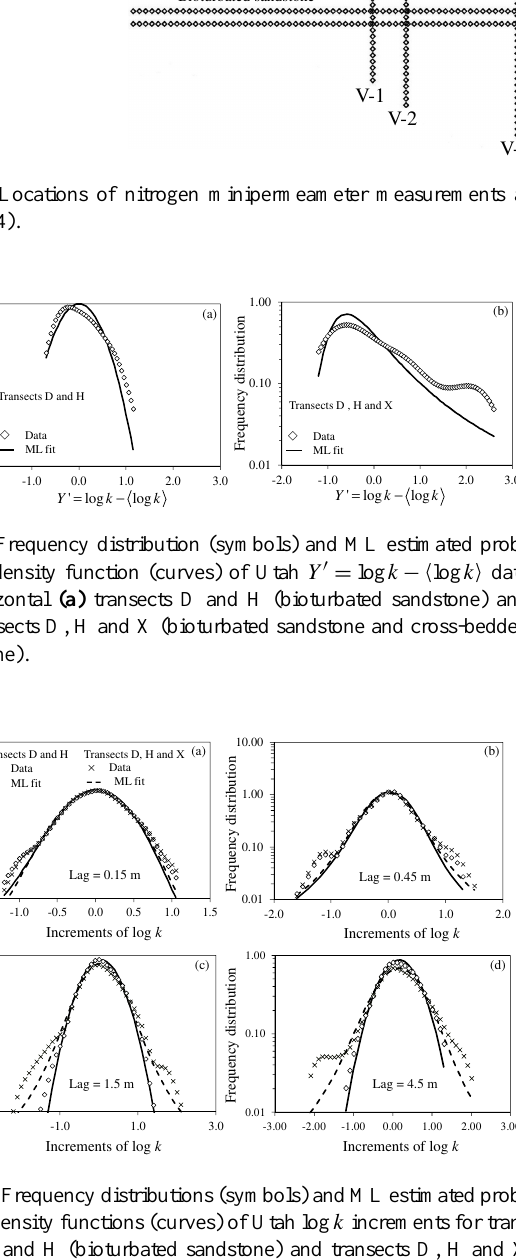
Fig. 10. Frequency distributions (symbols) and ML estimated prob- ability density functions (curves) of Utah log k increments for tran- sects D and H (bioturbated sandstone) and transects D, H and X (bioturbated sandstone and cross-bedded sandstone) at horizontal lags (a) 0.15m, (b) 0.45m, (c) 1.5m, and (d) 4.5m.